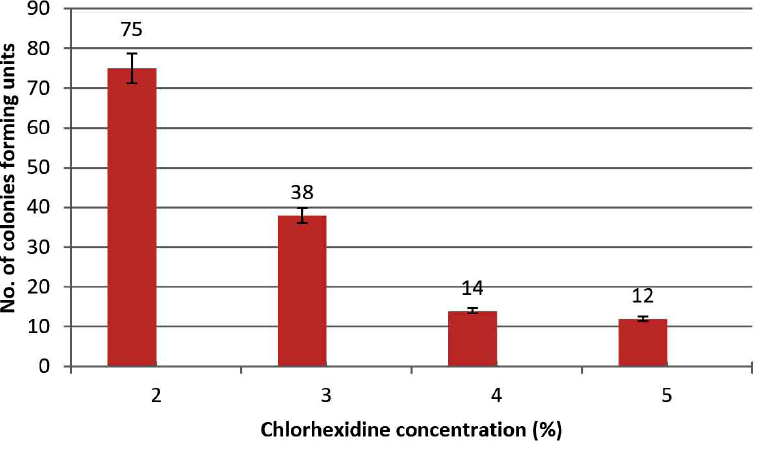
Fig. 2. Number of colonies forming units (CFU) on agar plate resulted from growth of B. thuringiensis spores after spreads 0.1 ml of spore suspension from surgical tools treated with Chlorhexidine solution.